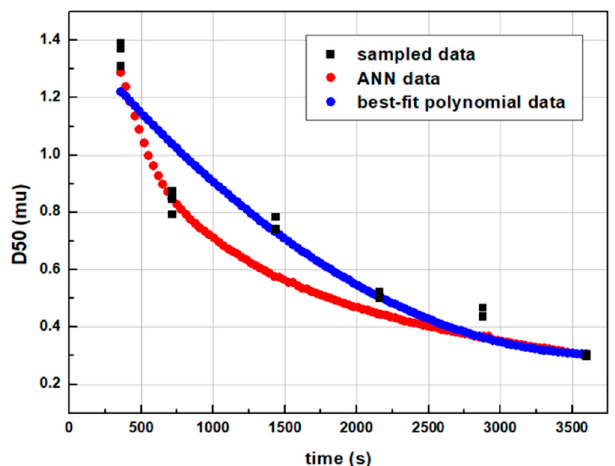
Figure 3. Wet milling dynamic comminution profile of experimental data points, ANN generated and best-fit polynomial curve.